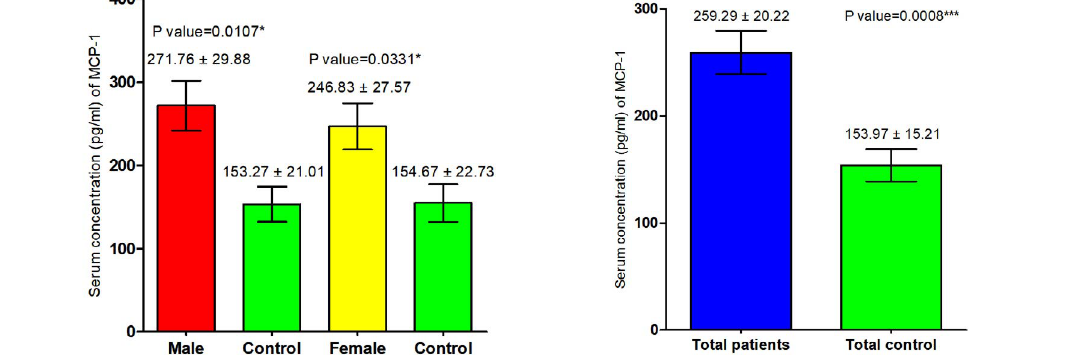
Fig. 5. Comparison between serum level of MCP-1 in male and female with Sarcoptes scabiei and control group